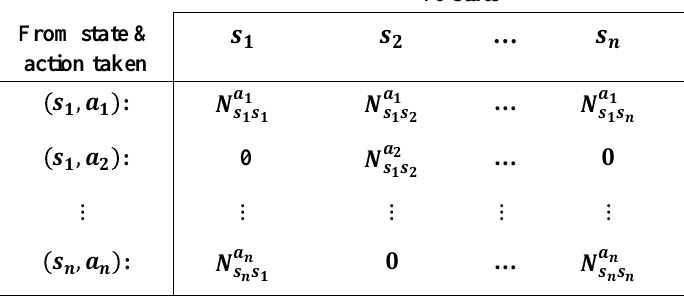
Figure 2. Table of the cumulative number of state–action pairs, where 0 represents the unreach- able